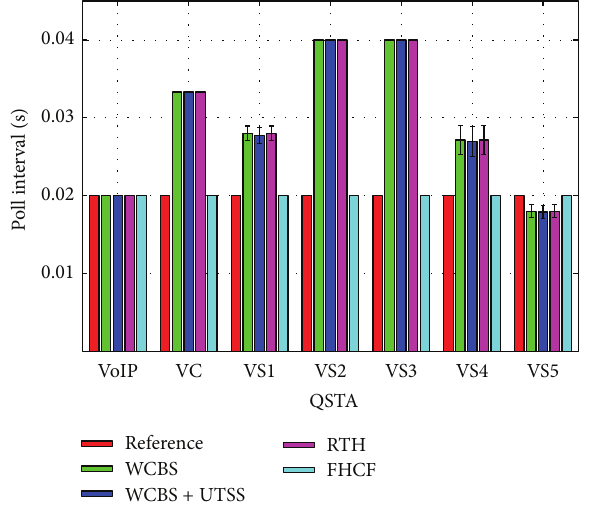
Figure 9: Polling interval.